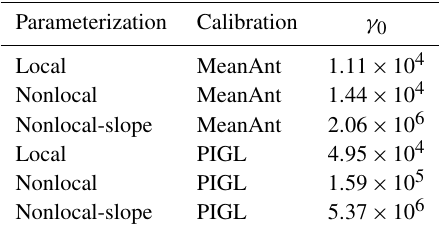
Table 1. Calibrated γ 0 values for the three quadratic parameteriza- tions and two calibration methods (in myr − 1